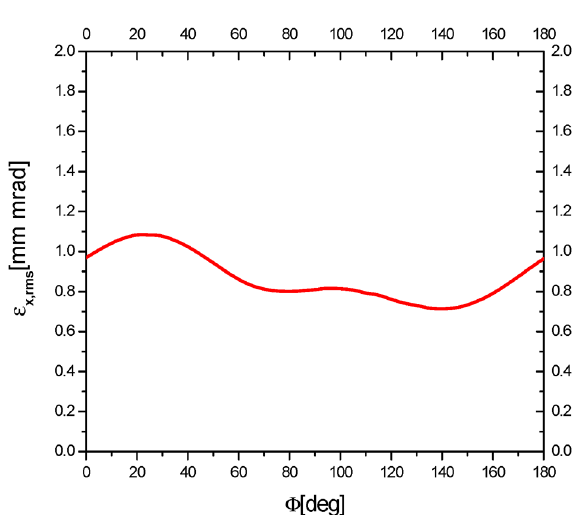
FIG. 8. (Color) Power deposition into the surface of the 3.5 cell , the TE , and the sum of the TM cavity for the TM 010 011 mode along the cavity TE 011